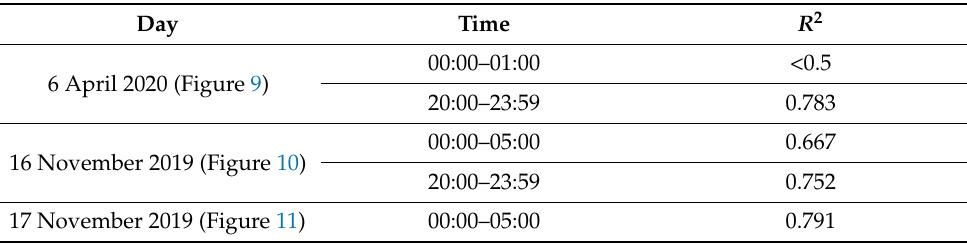
Table 6. R 2 values for several days that were not included in the regression method.